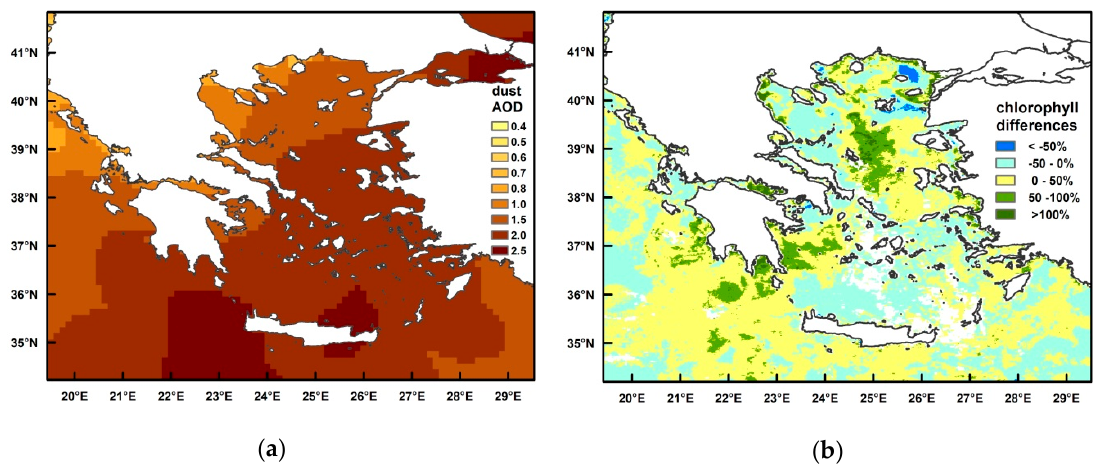
Figure 2. ( a ) Maximum dust aerosol optical depth (AOD) during the episode 25–28 March 2015; ( b ) Chl-a % differences between the weeks before (14–21 March 2015) and after (30 March–6 April 2015) the the event.